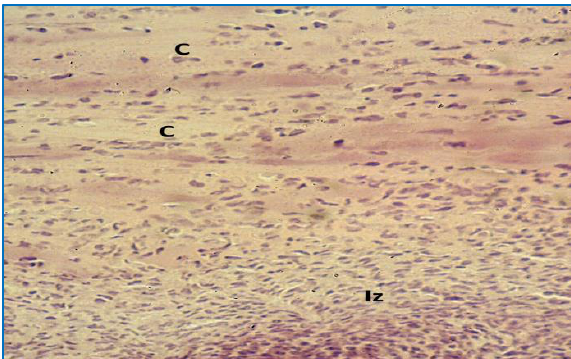
Figure, 4: Section of skin (7 days post injury-control) shows: Inflammatory zone (Iz) and clot fibrin. H and E stain. 400x.